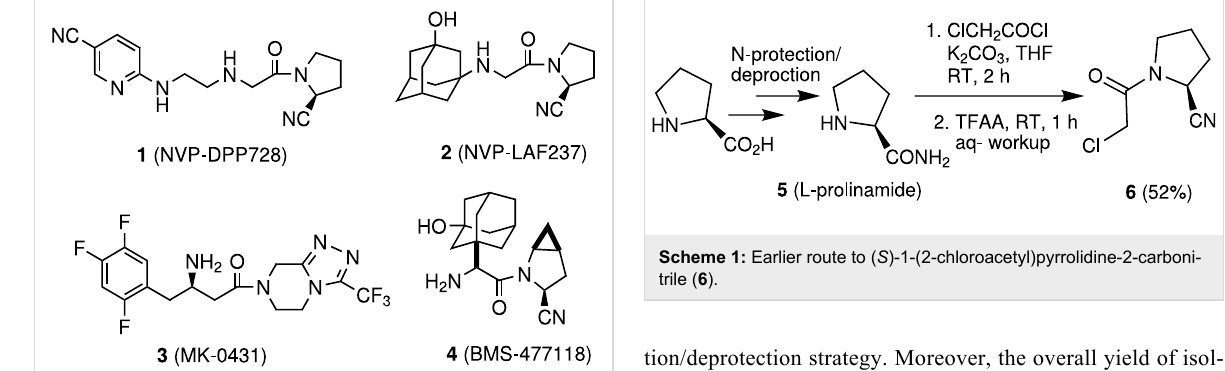
Figure 1: DPP-IV Inhibitors.